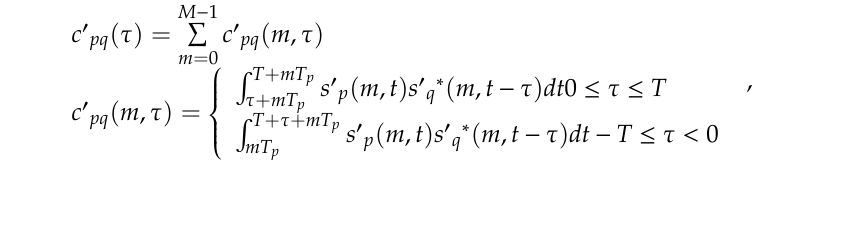
Figure 6. Time-frequency structure of designed OFDM chirp waveform, M = 16. ( a ) During a pulse and